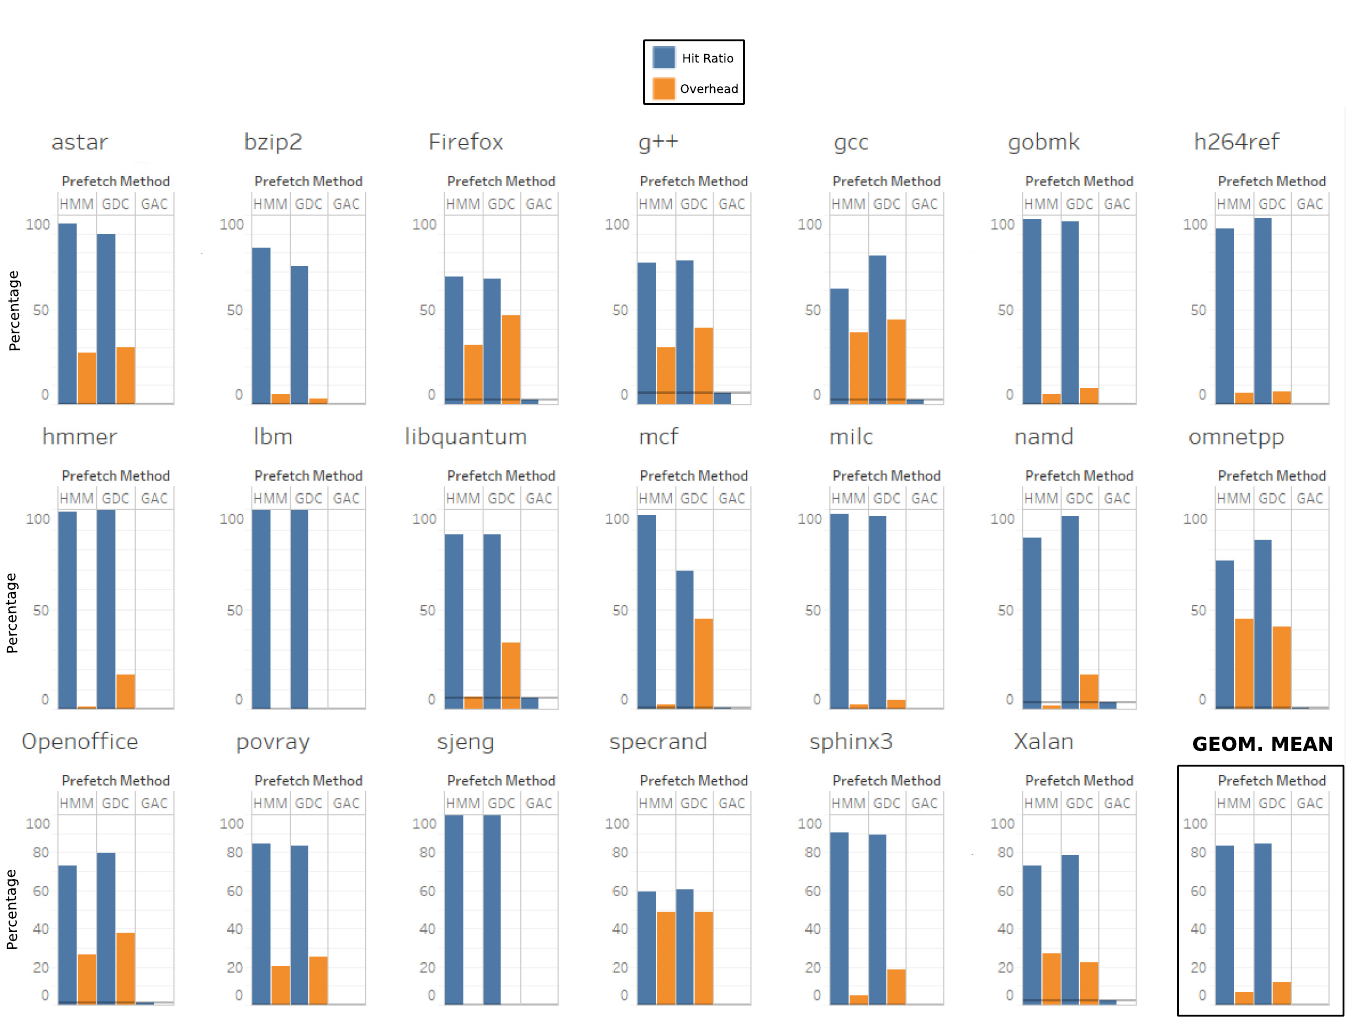
Fig 11. Hit ratio and overhead of BASE , HMM , G / DC and G / AC in a single core architecture. The hit ratio for the BASE experiment is represented by a horizontal line (0-6.3% for all benchmarks). The last plot is the geometric mean of all benchmarks.